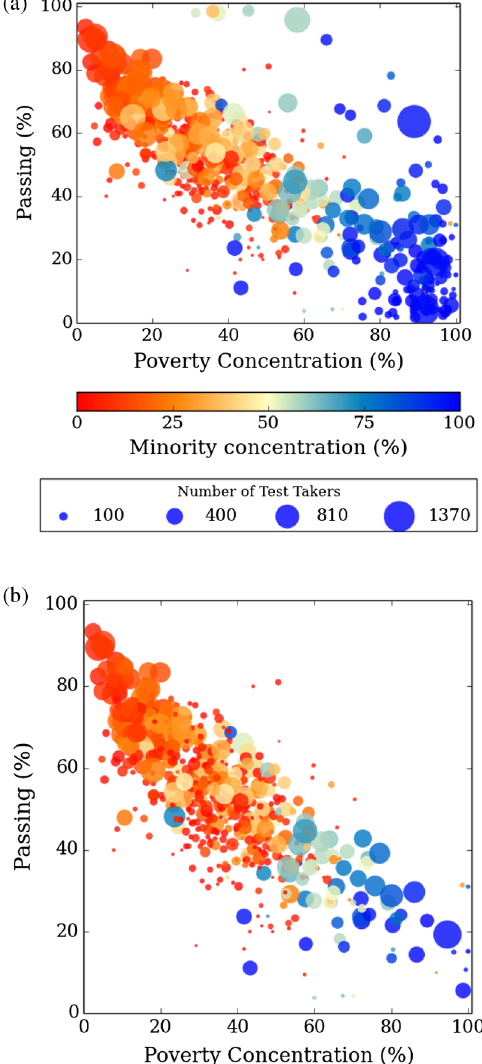
FIG. 1. (a) Percent of 11th graders at each Illinois school who passed the 2013 Math PSAE as a function of poverty concen- tration. The area of each point represents the number of test takers, and the color represents the percentage of minority students. (b) Same as (a) but excluding Chicago schools. It becomes particularly clear that Illinois school performance is very tightly correlated with poverty concentration and concen- tration of minority students.